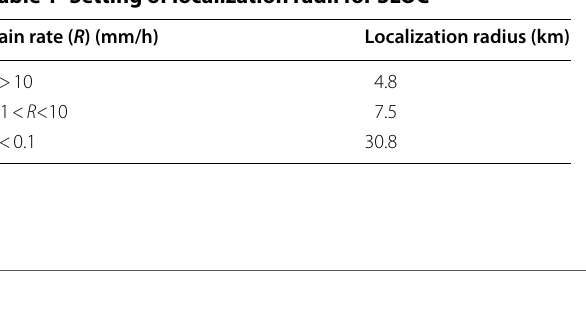
Table 1 Setting of localization radii for SLOC